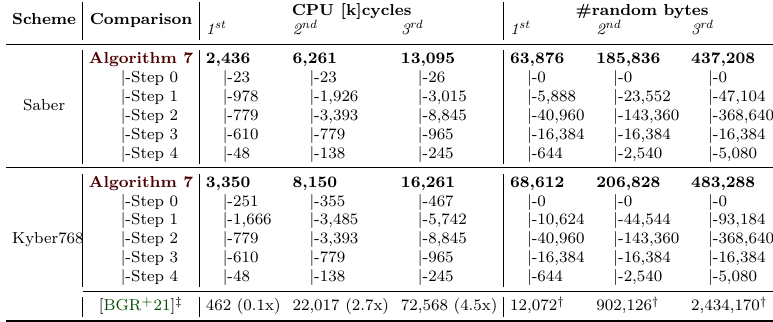
Table 4: Performance breakdown of our masked comparison on ARM Cortex-M4 with collision probability 2 − s = 2 − 128 Scheme